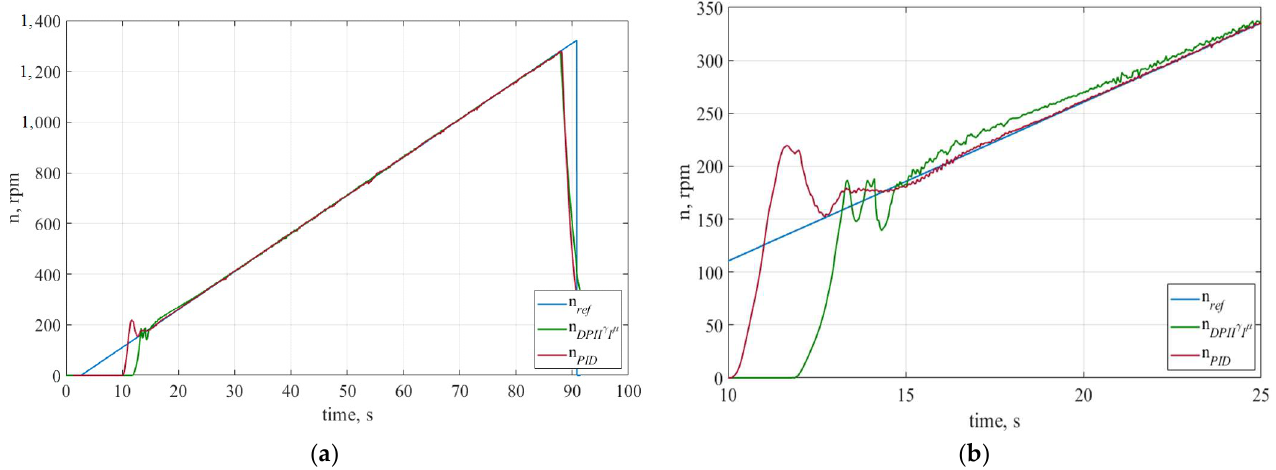
Figure 12. Graphs of transient processes of the average speed of the wheels when measuring power ( a ); enlarged fragment at the beginning of acceleration ( b ).